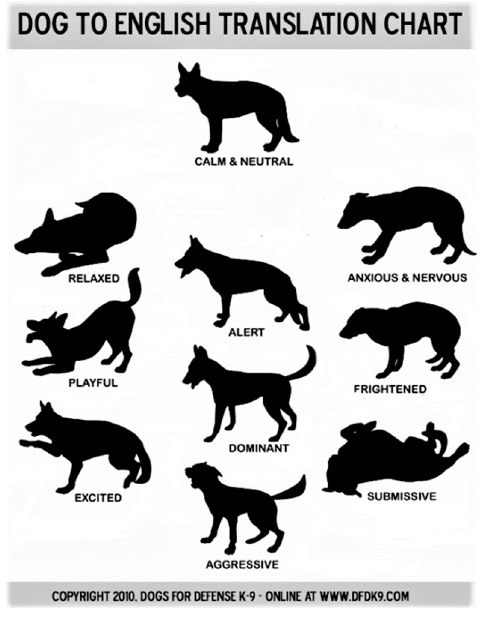
Figure 5. Dogs for Defense, www.DFDK9.com. Image courtesy of Chris Crawford.